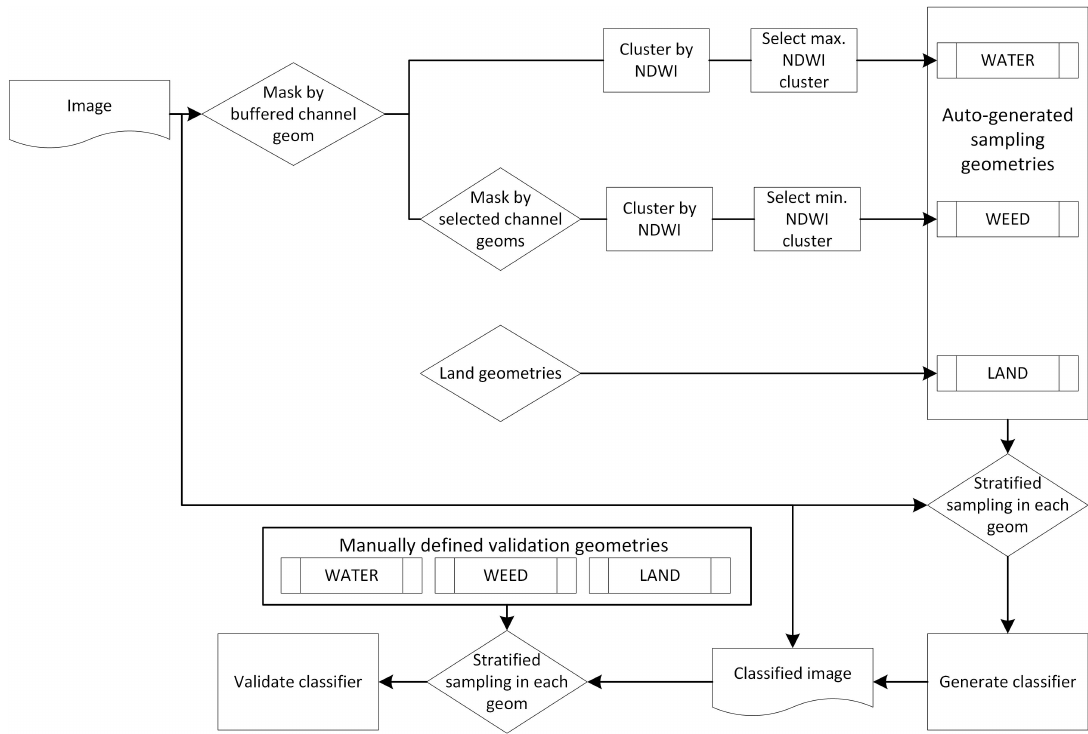
Figure 3. Method of generating a classified image from a satellite image. The land and selected channel geometries are constant across images, so a new classifier is generated for each image without a user needing to manually define new water, land and weed